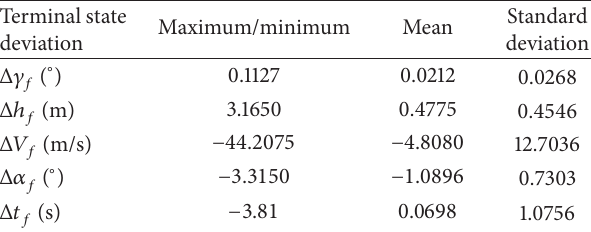
Table 6: Monte Carlo simulations statistic